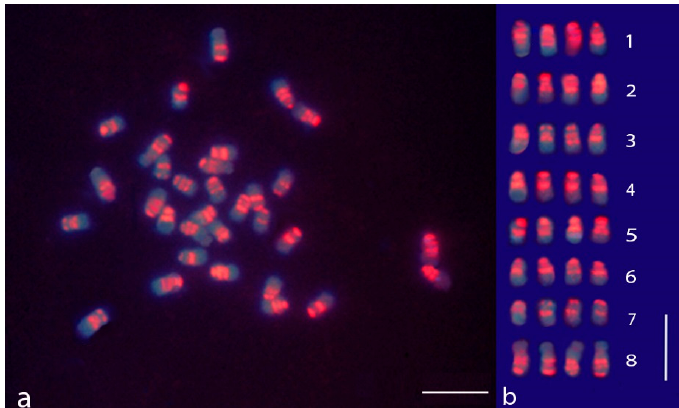
Figure 1. Self-genomic in situ hybridization (sGISH) banding in chromosomes of M. sativa subsp. sativa displaying the localization of highly repeated DNA sequences (satDNA) . ( a ) Mitotic metaphase after the sGISH treatment; ( b ) karyogram of the sGISH-banding metaphase shown in Figure 1a; the chromosomes were arranged according to their morphological traits and the sGISH signal